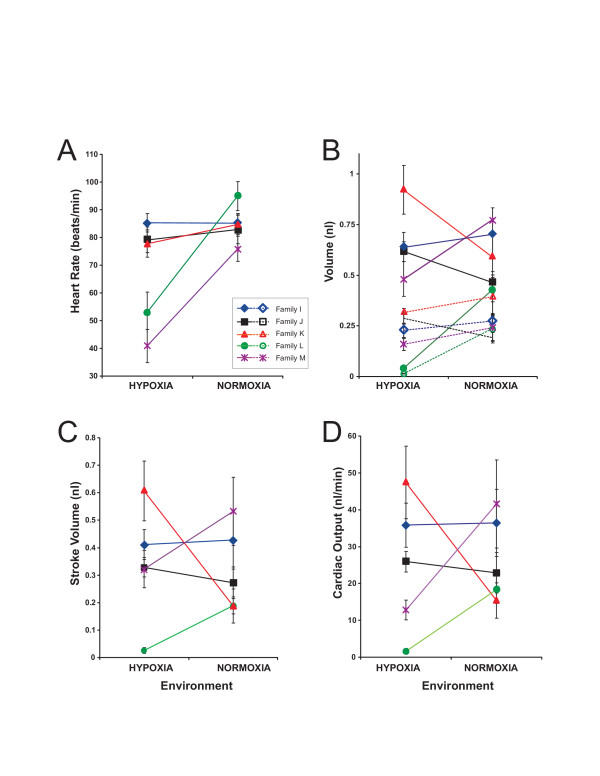
Cardiac performance by family and environment. Family means for; A) Heart Rate in beats/min, B) end systolic (open symbols) and diastolic (closed symbols) volume in nl, C) stroke volume in nl, and D) cardiac output in nl/min are presented for larvae reared in normoxic and hypoxic environments. Error bars represent one standard error. Family and Family × Environment interactions were significant sources of variation in all five traits, while a direct effect of Environment was only significant in heart rate and ESV.